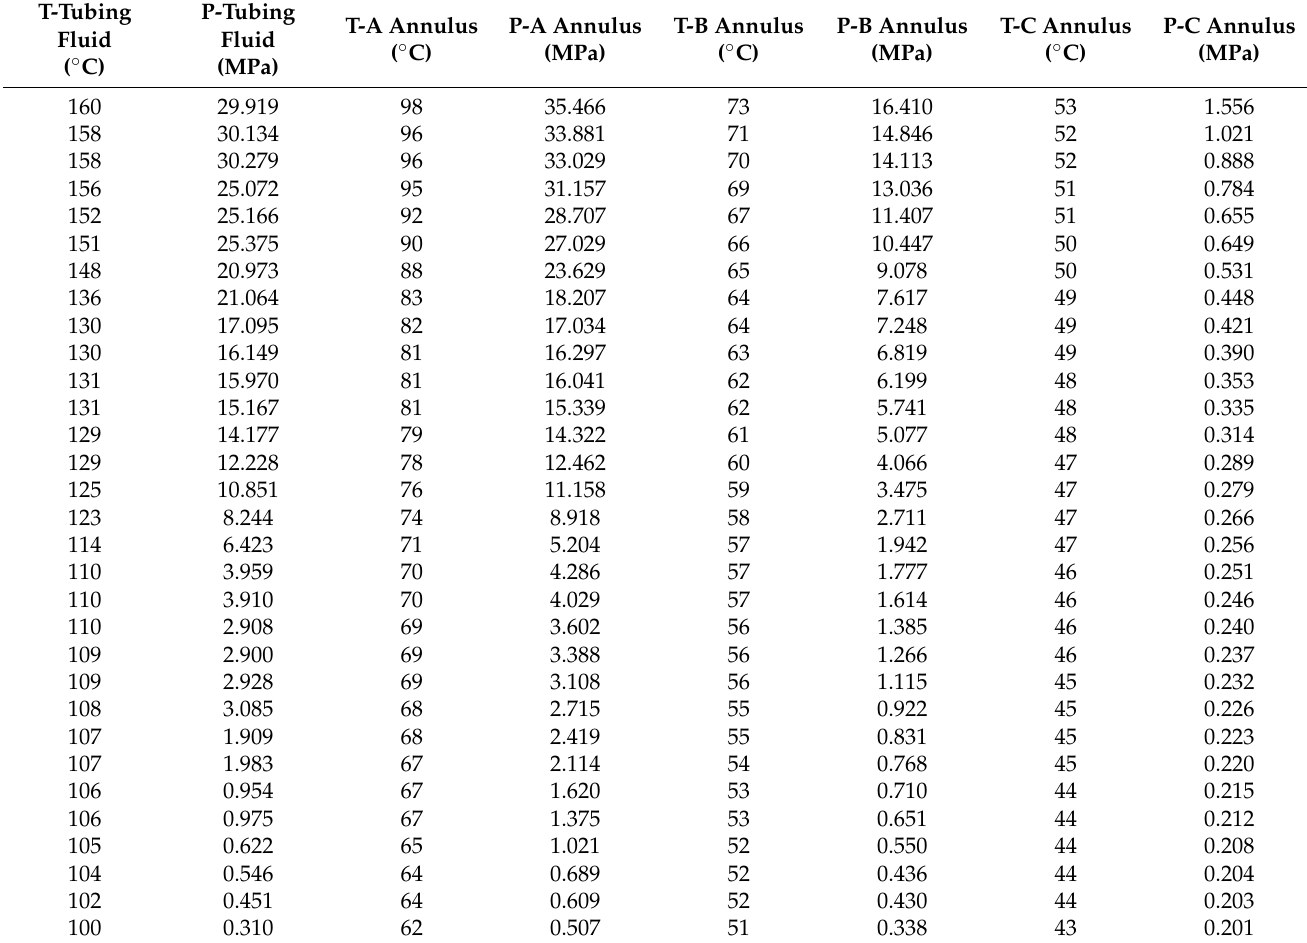
Table 2. Experimental data of temperature and pressure of each